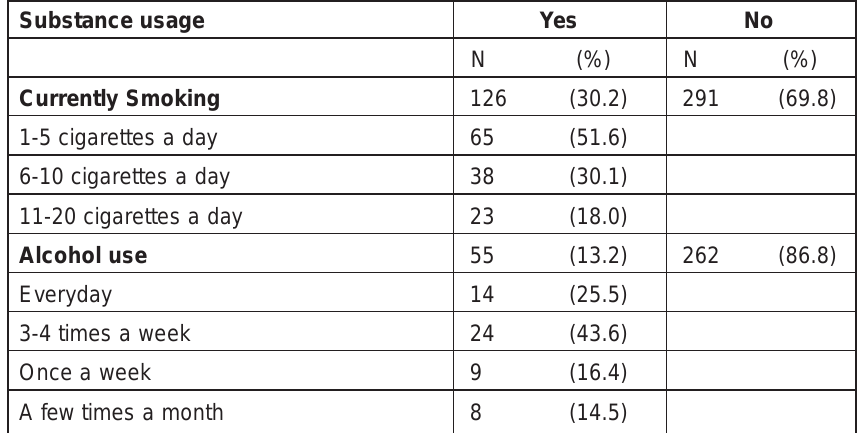
Table 4: Participants smoking and using